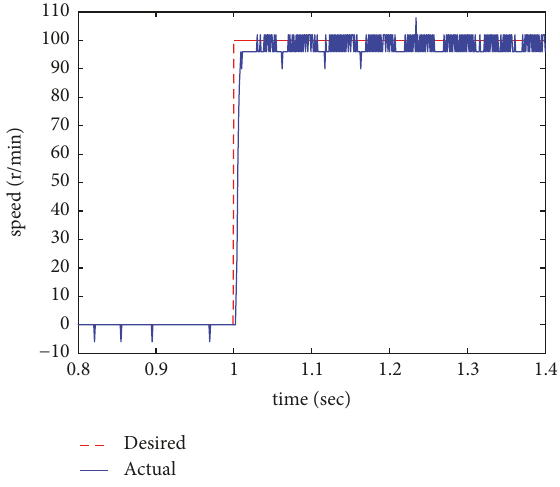
Figure 2: Step response curve of servo